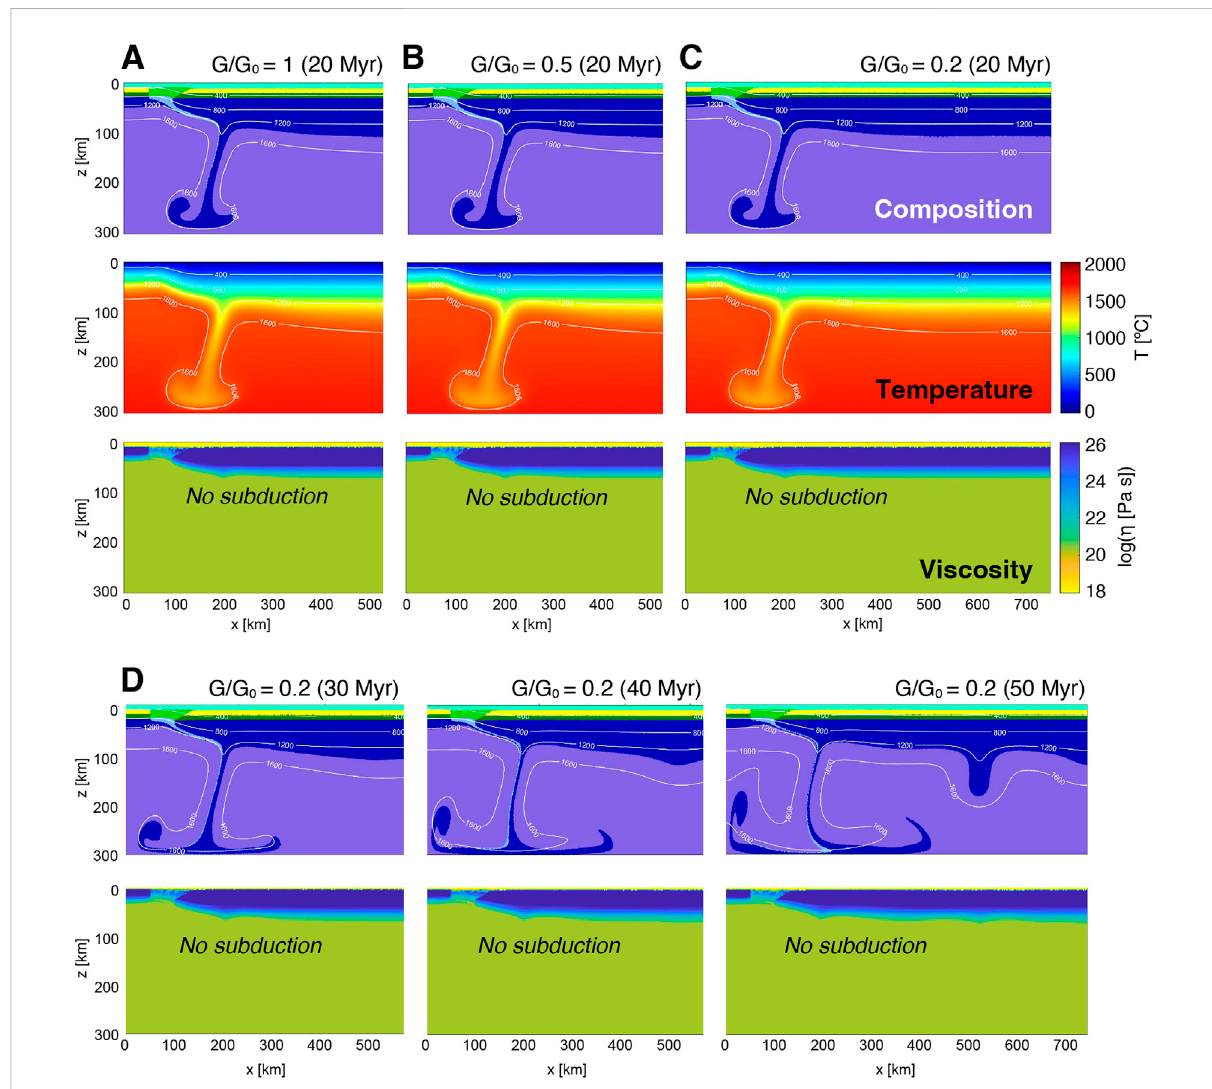
FIGURE 8 Results of numerical modeling for dry condition in both shallower and deeper crust. (A – C) Snapshot of simulation results using (A) G / G 0 = 1 (B) G / G G / G 0 = 0.5, and (C) 0 = 0.2 at 20 Myr after the start of the simulation. Plate subduction does not occur in any cases (D) Snapshot of simulation resultsusing G / G 0 =0.2 at30,40,and50Myrafterthestartofthesimulation.Theuppermantleviscosity η um wasassumedtobe2×10 20 Pa ssameas the wet